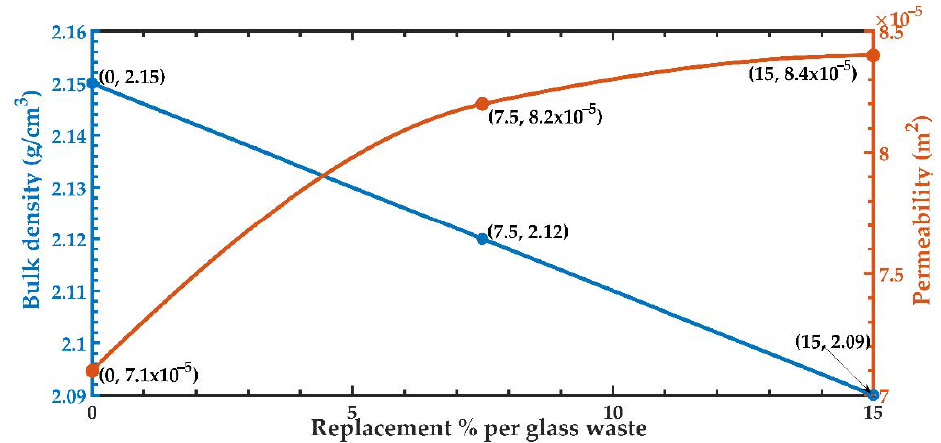
Figure 5. Results of bulk density and permeability versus glass particle fraction. Reprinted with permission from [45]. Copyright©2015, Elsevier B.V.